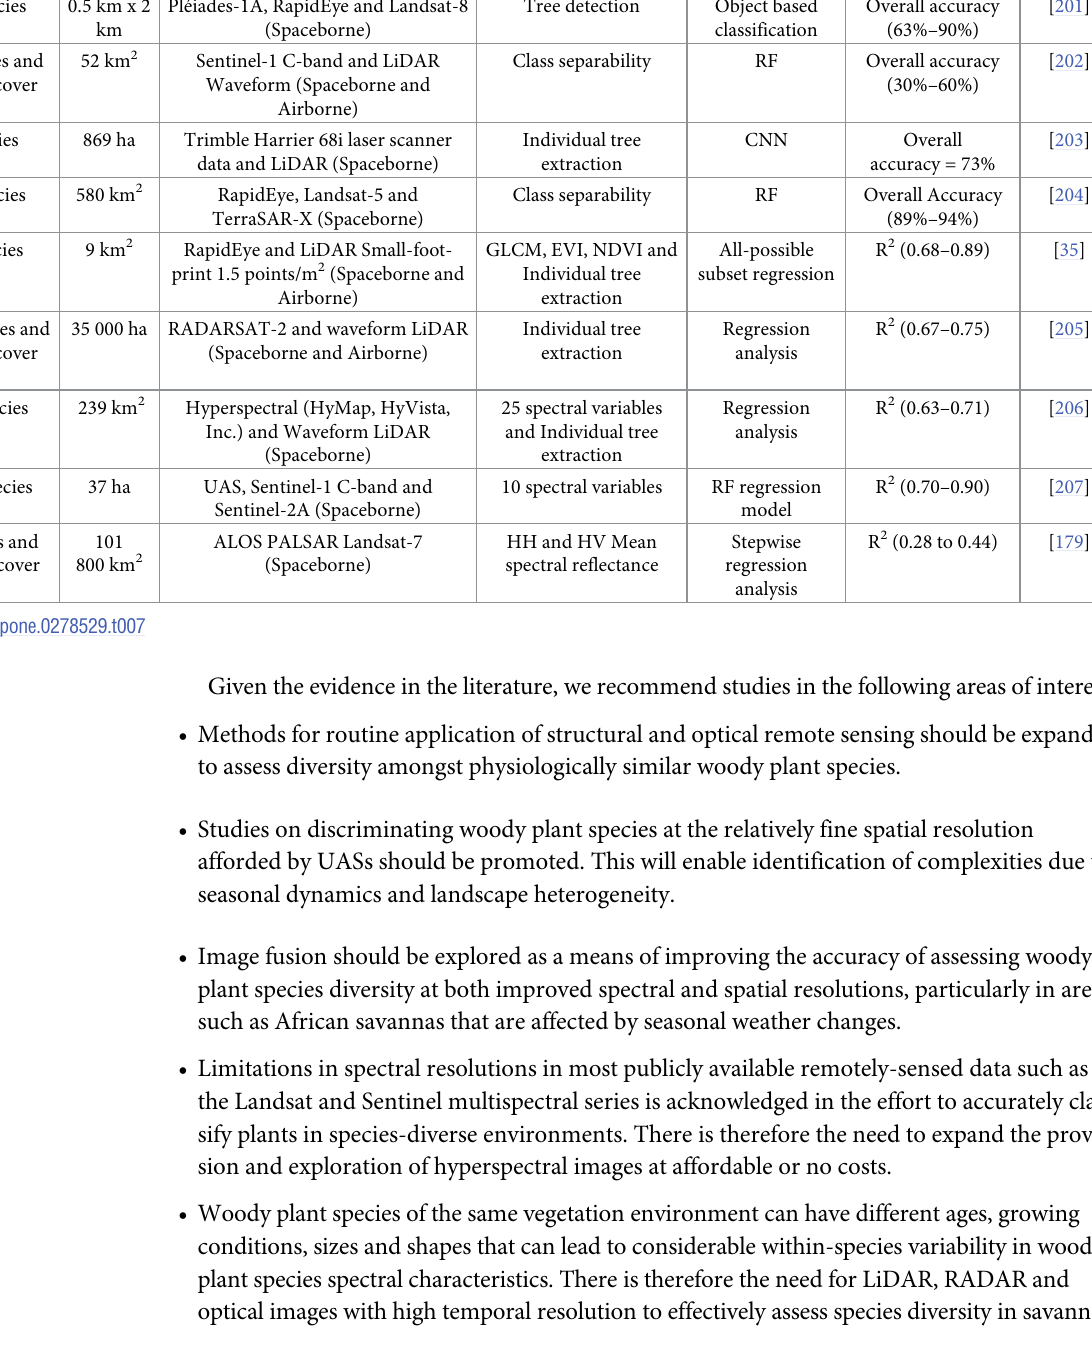
Table 7. Examples of studies that classified species types in savanna environment using categorical/continuous-scale approaches. Savana Biome